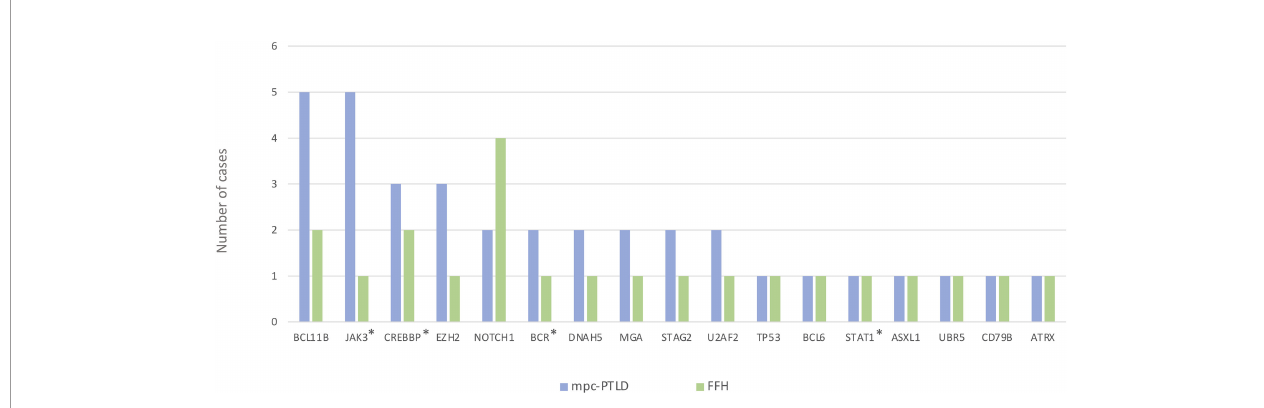
FIGURE 3 | Genes mutated in the mpc-PTLD and FFH-PTLD groups. *Genes affecting the JAK/STAT pathway.